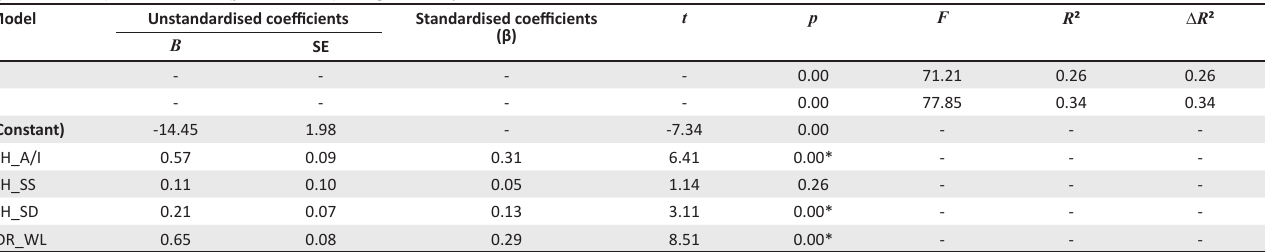
TABLE 3: Multiple regression with emotional exhaustion (burnout) being the dependent variable and anxiety and insomnia, somatic symptoms and social dysfunction (general health), and workload (job demands) being the independent variables.